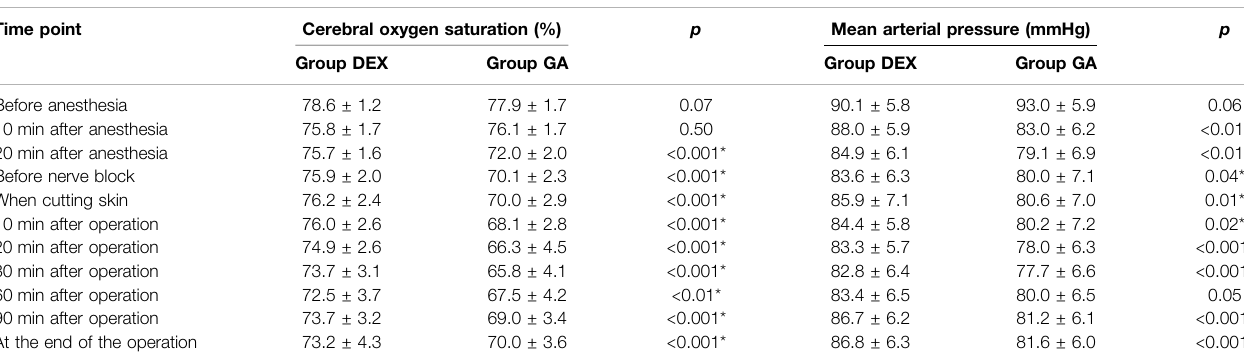
TABLE 2 | Analysis of intraoperative cerebral oxygen saturation and hemodynamics (Mean ± SD). Time